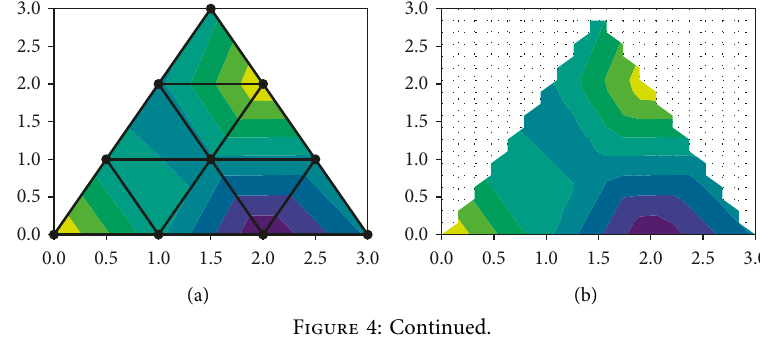
Figure 3: Convolutional combination of voids with expansion factor [2 2 2]. (a) Layer 2 convolution output feature map. (b) Layer 1 convolution output feature map. (c) Input feature